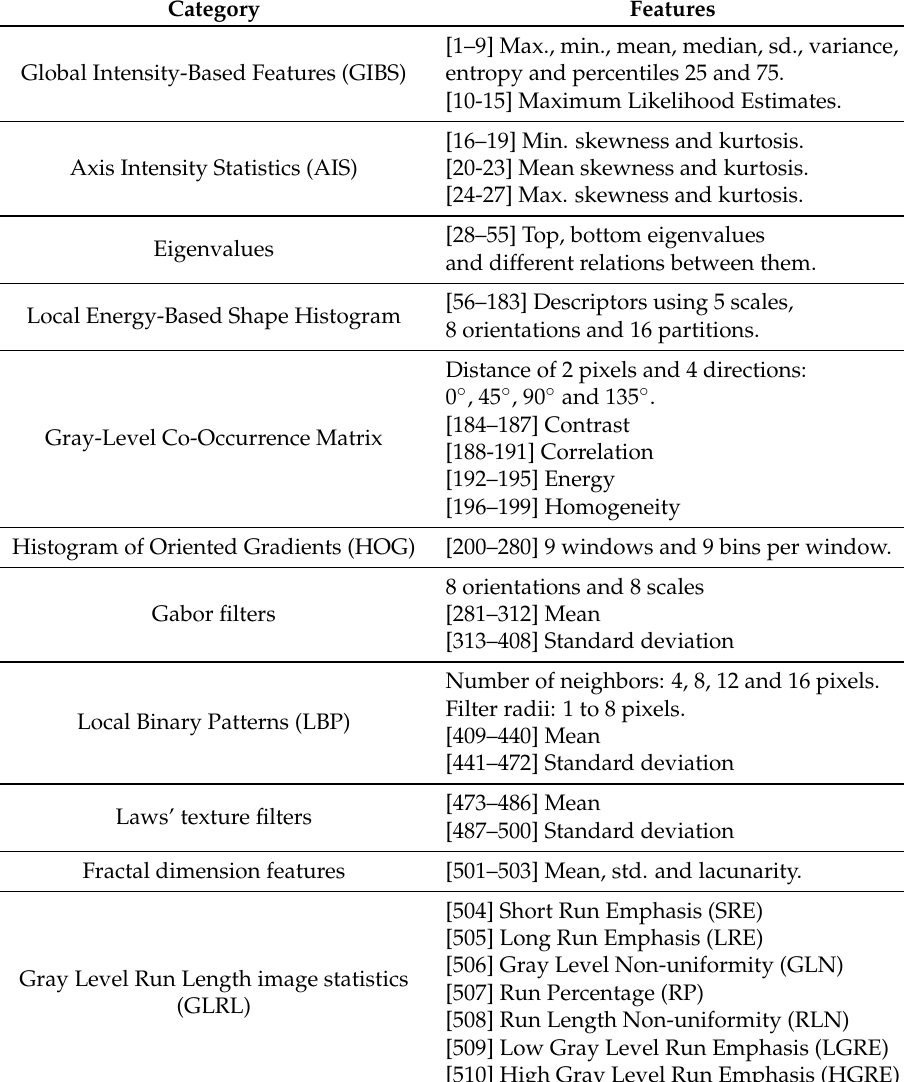
Table 1. Measured features. max - Maximum; min - Minimum; sd - Standard